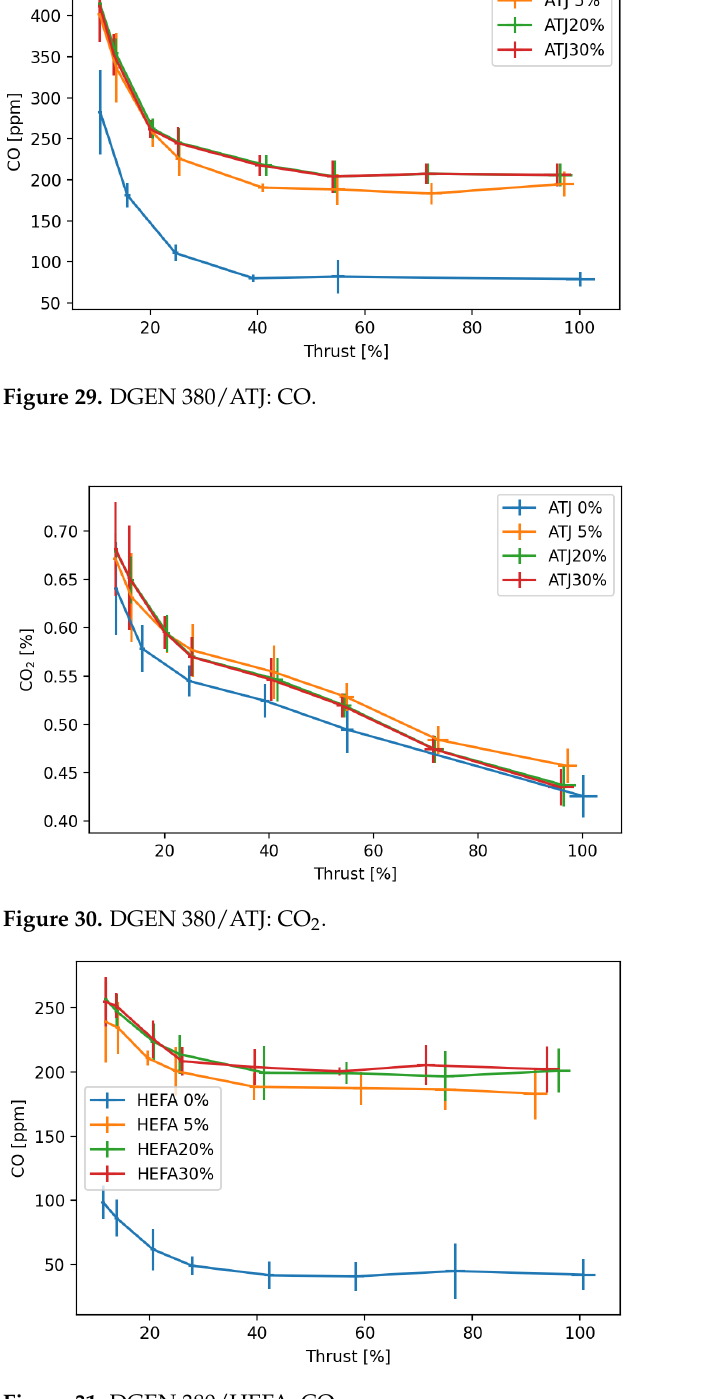
Figure 31. DGEN 380/HEFA: